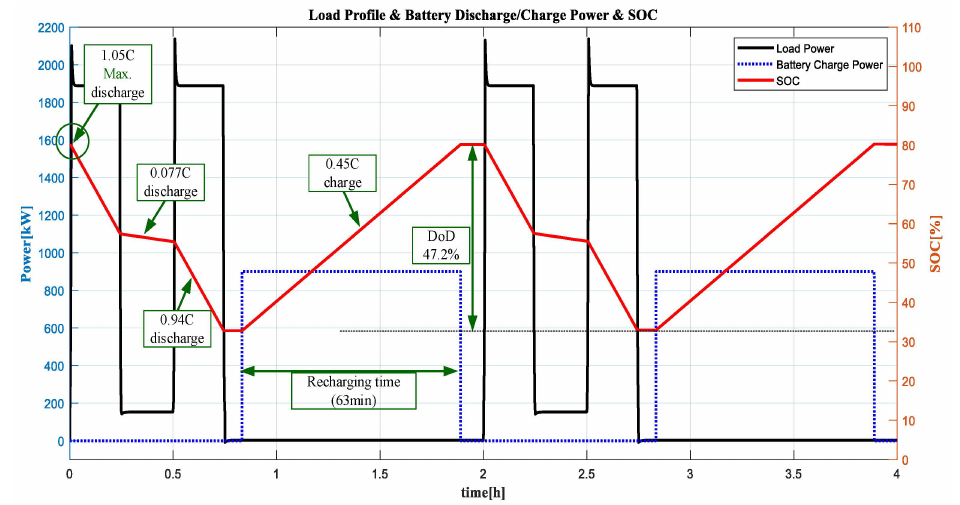
Figure 8. BESS charge/discharge profile according to target vessel